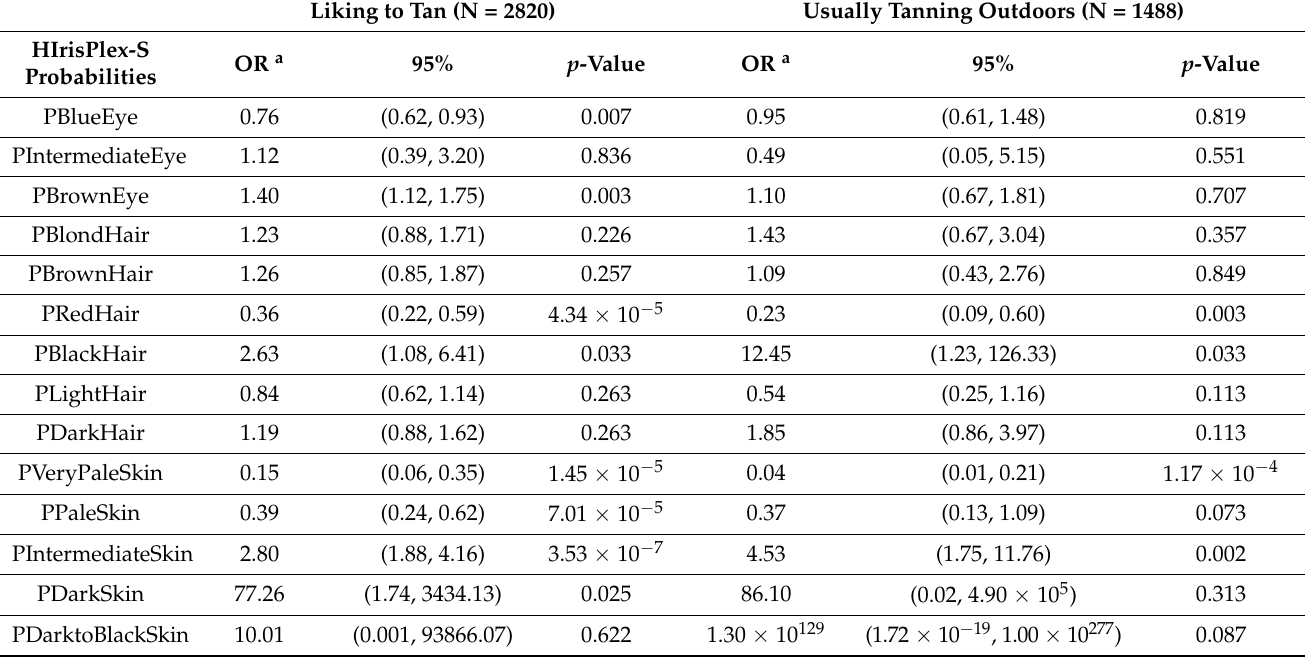
Table 4. Association of liking to tan and usually tanning outdoors with HIrisPlex-S prediction probabilities of pigmentation traits in ALSPAC young people